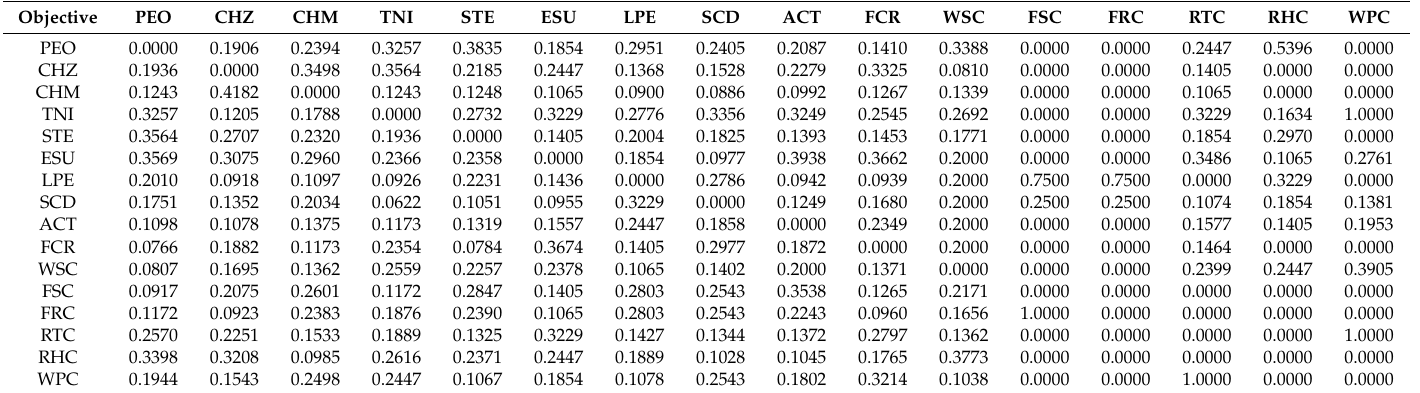
Table 5. Unweighted supermatrix for temporary facility layout plan selection.